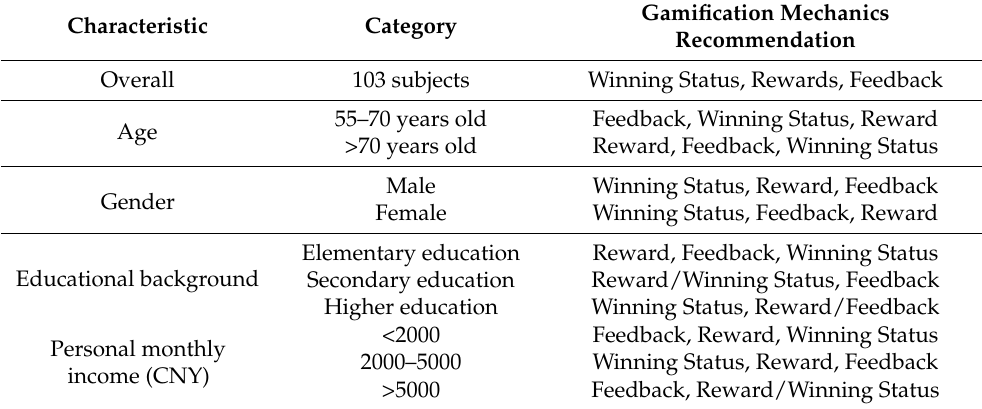
Table 11. Recommended gamification mechanics for older adults with different characteristics.